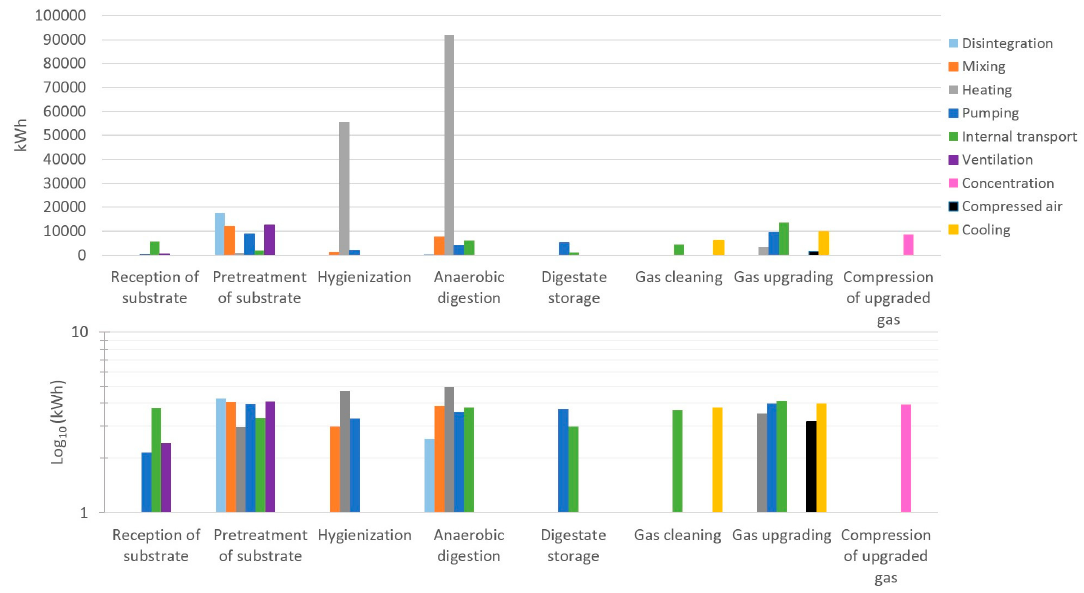
Figure 17. The energy use for 30 days for plant B, presented in a combination of sub-processes and unit processes. The lower diagram has a logarithmic scale.